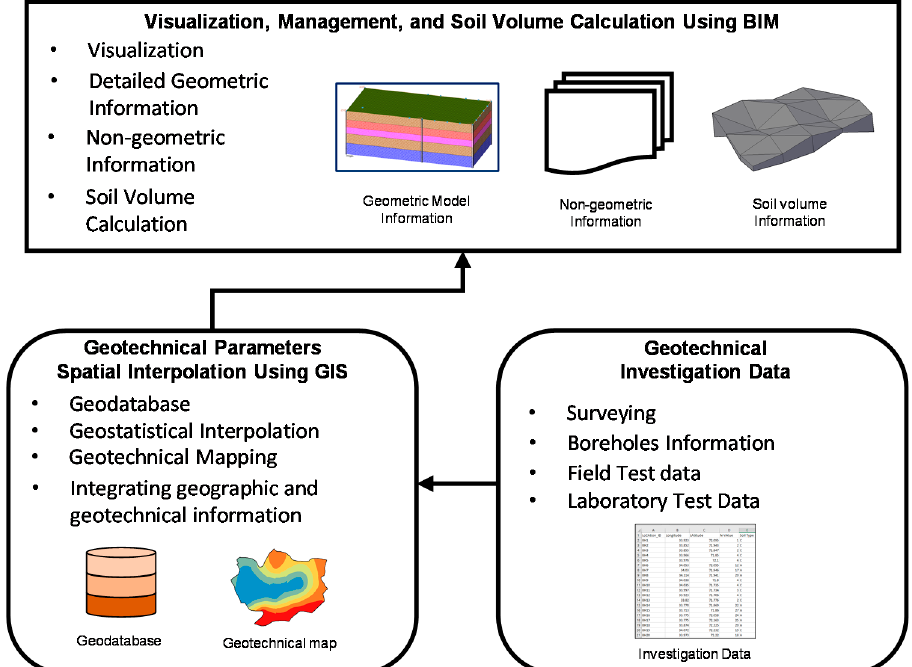
Figure 1. Concept